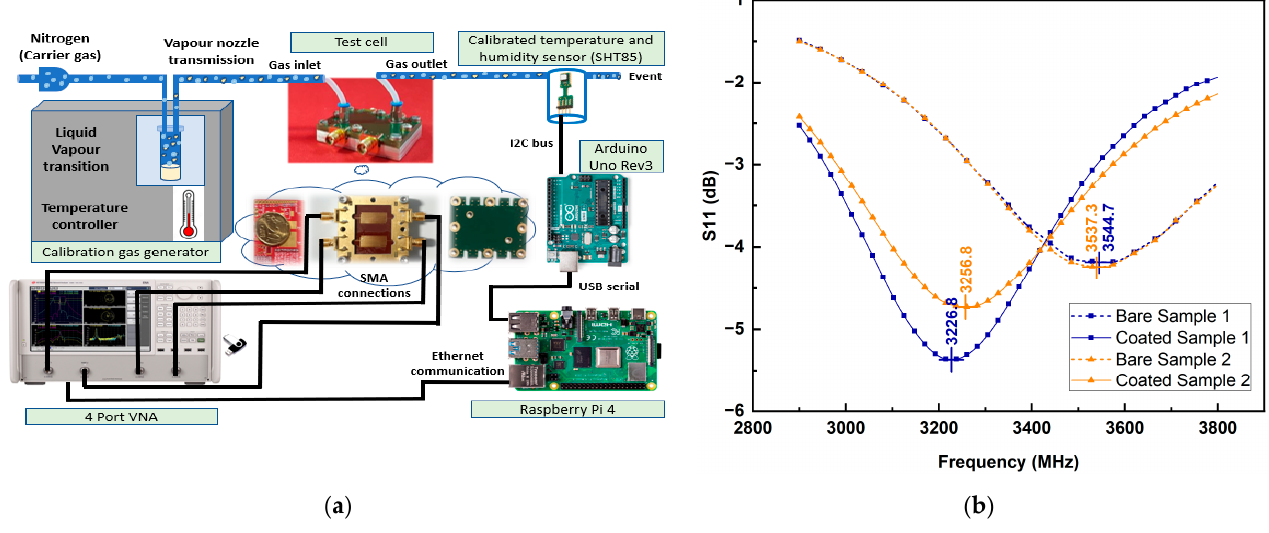
Figure 5. ( a ) Schematic diagram of the experimental setup ( b ) Sample 1 and sample 2 experimental S 11 parameters .